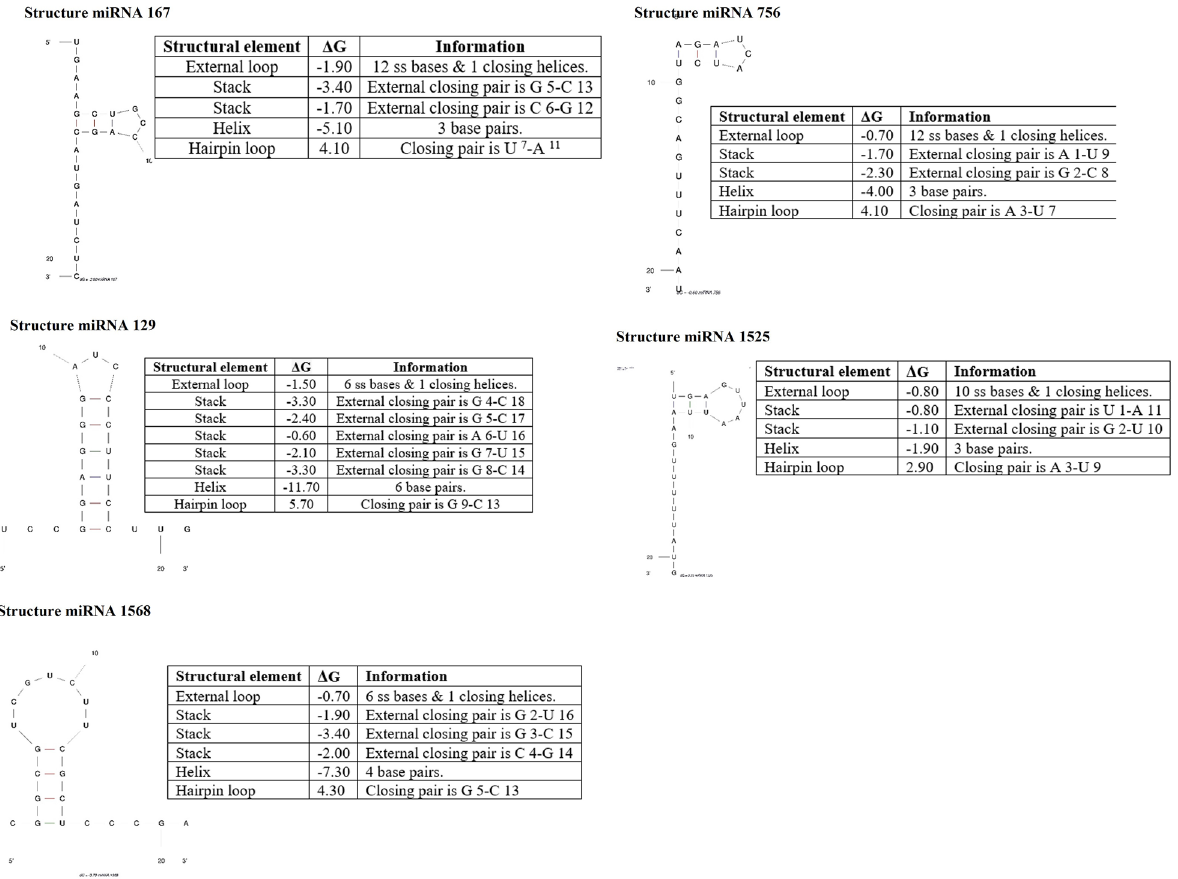
Fig. 5 The structure prediction of C. longa miRNA by